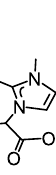
Figure 6. Complex 3 .